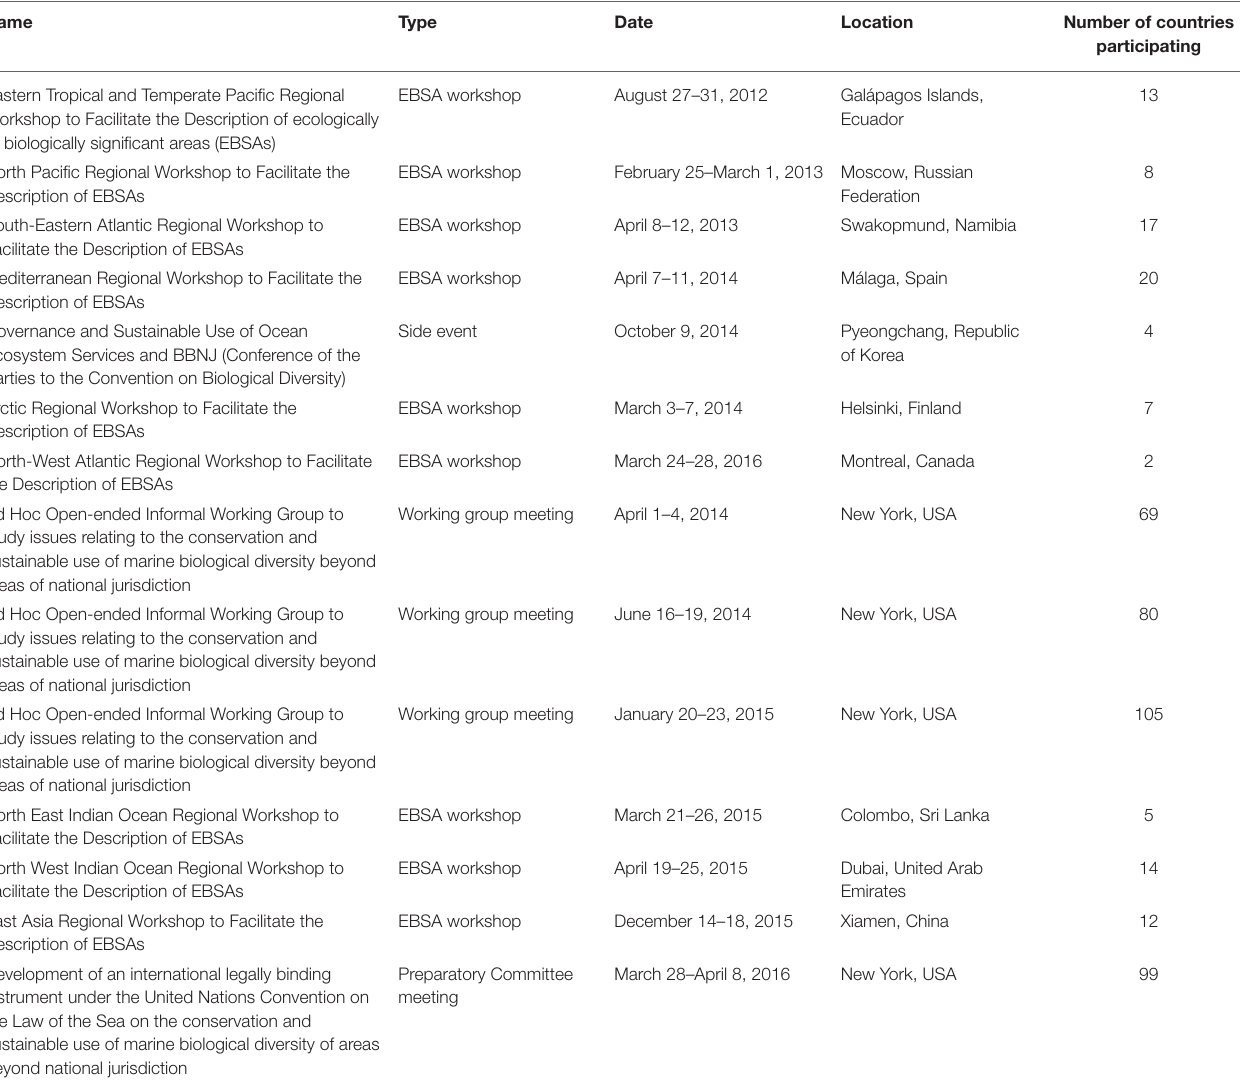
TABLE 1 | Meetings included in the network